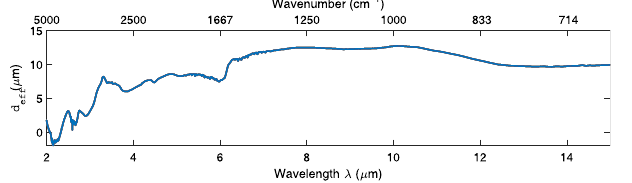
Figure 2. Empirical effective penetration depth d eff calculated from the measured absorbance and literature k values of water. The dashed trace at wavelengths < 2.7 μ m show the region where d eff has been calculated from a ratio where both quantities are approximately equal to zero so cannot be relied